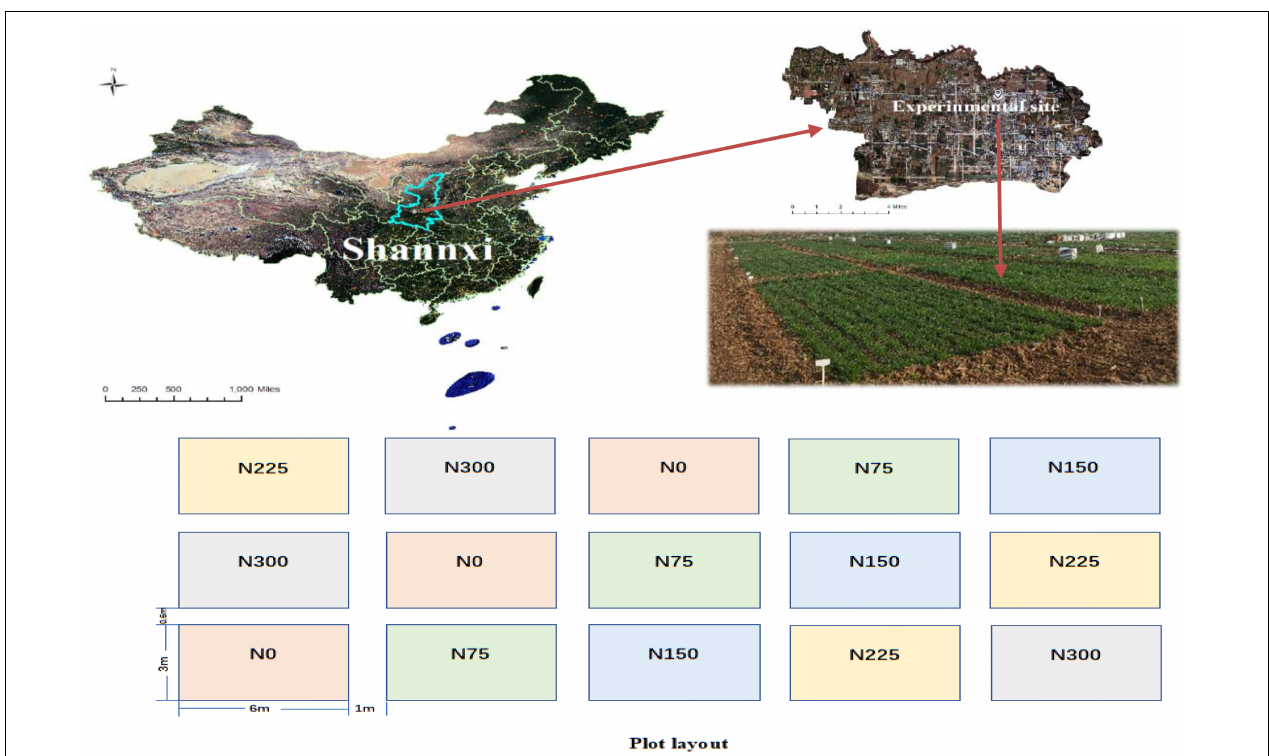
FIGURE 1 | Location of the experimental site and layout of the field plots randomly distributed with N application rates. N0, unfertilized control; N75, 75 kg N · ha – 1 ; N150, 150 kg N · ha – 1 ; N225, 225 kg N · ha – 1 ; N300, a traditional N application rate 300 kg N · ha – 1 .